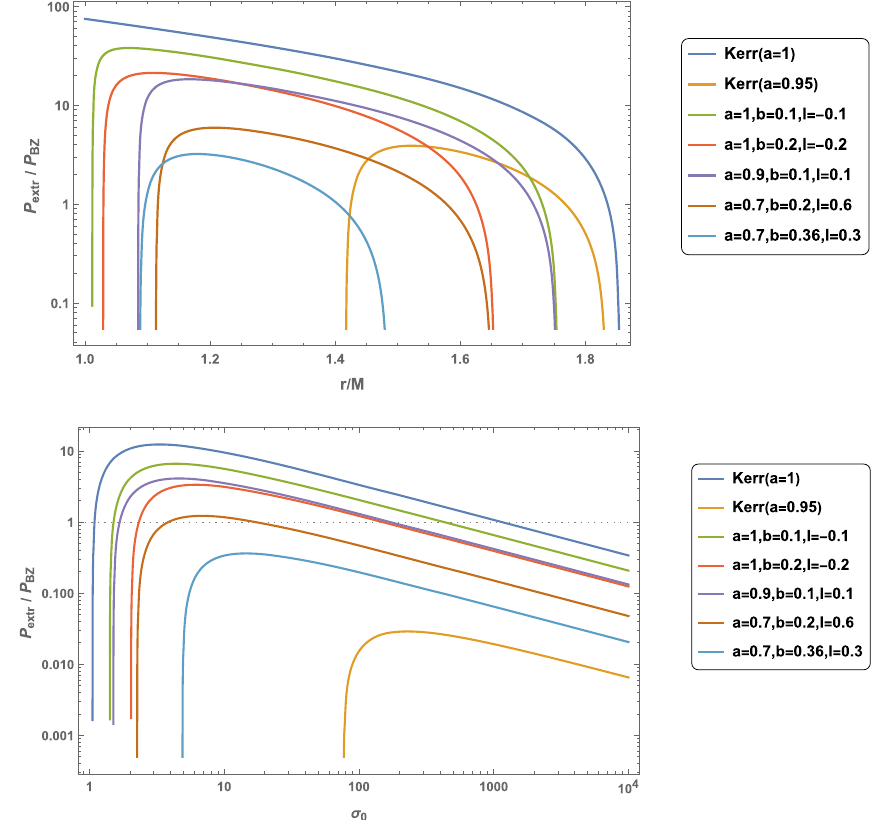
Fig. 4 (Top) Rate between power extracted from magnetic reconnec- tion and the same quantity from BZ mechanism, as function of the X- point distance, with ξ = π/ 12 and σ 0 = 10. (Bottom) The same quan-